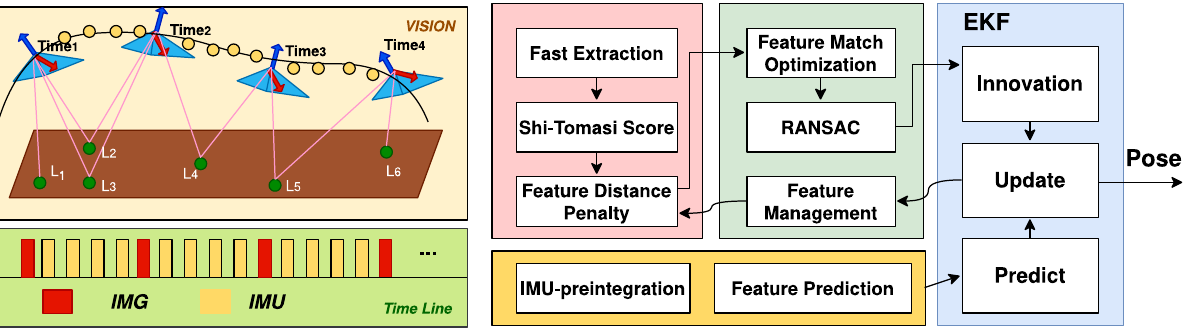
Figure 2. The overall procedure of the visual–inertial odometry.